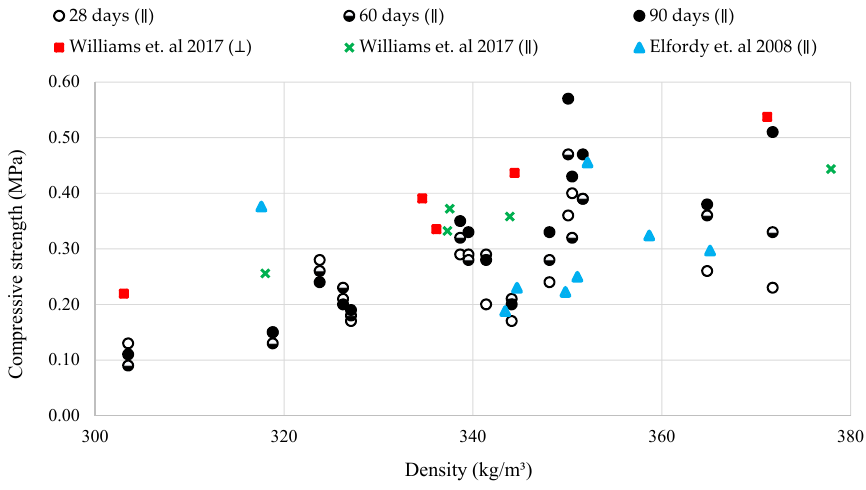
Figure 2. Comparison of density, compressive strength, and age.